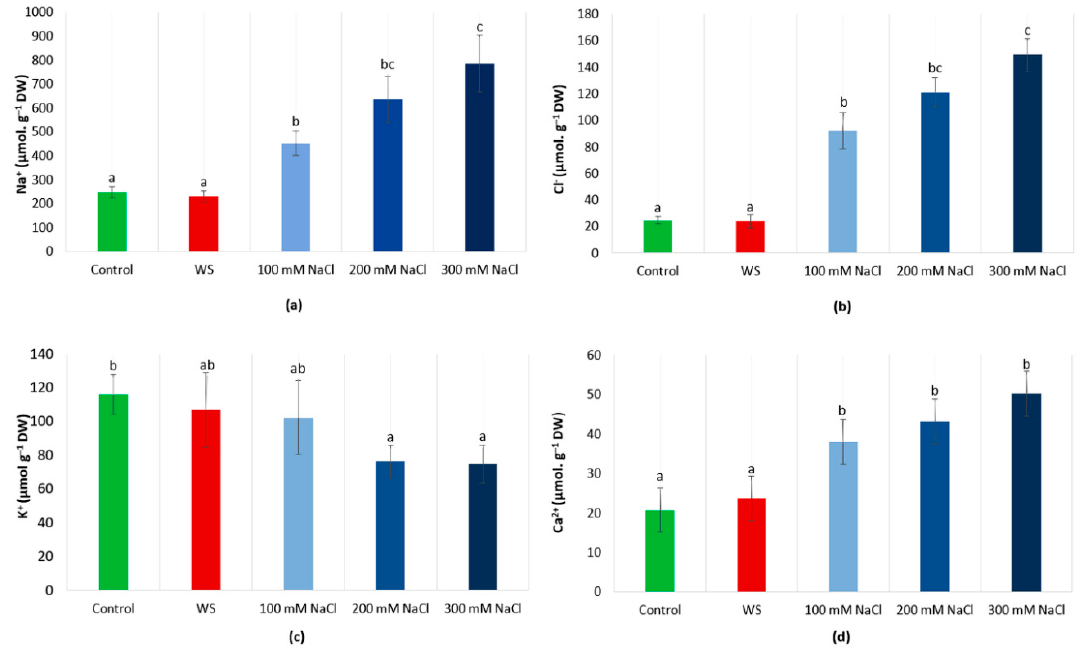
Figure 3. Ion contents in roots of one-year-old A. alba seedlings after 30 days of growth in the presence of the indicated NaCl concentrations or subjected to water deficit stress (WS). ( a ) sodium, ( b ) chloride, ( c ) potassium, ( d ) calcium. Bars represent means ± SE ( n = 7). Different letters above the bars indicate significant differences between treatments, according to Tukey’s test ( α = 0.05).